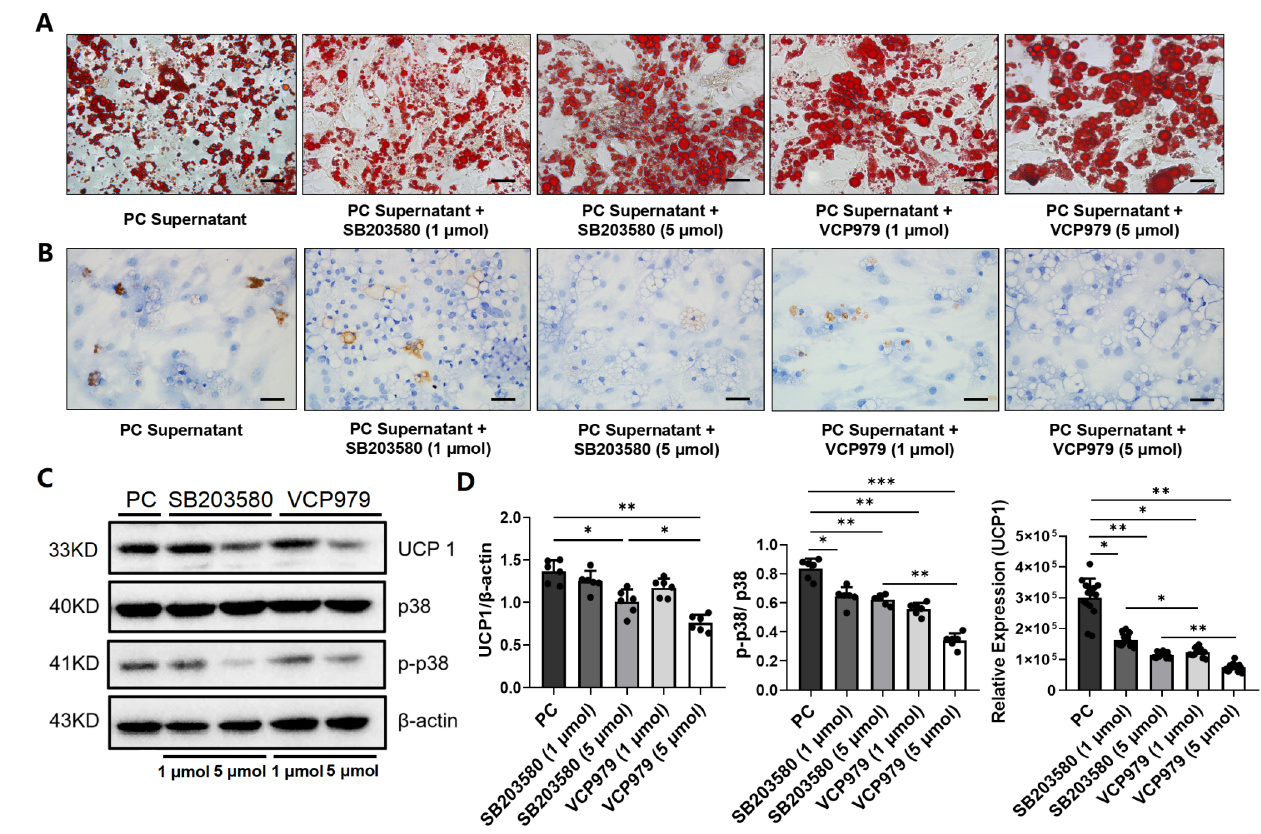
Figure 3. The effect of p38 MAPK inhibitors on the expression of UPC1 and levels of p-38, p-p38 and lipid droplets. ( A ) Oil Red O staining of primary white adipocytes under five different treatment conditions. ( B ) The IHC staining of UCP1 protein in primary white adipocytes under five different intervention conditions. ( C ) The Western blotting of the expression level of UCP1. ( D ) The expression level of UCP1, p38 and p-p38 in primary white adipocytes under five different intervention conditions. (* p < 0.05, ** p < 0.01, *** p < 0.001). p- = phosphorylated, PC = pancreatic cancer, UCP1 = uncoupling protein